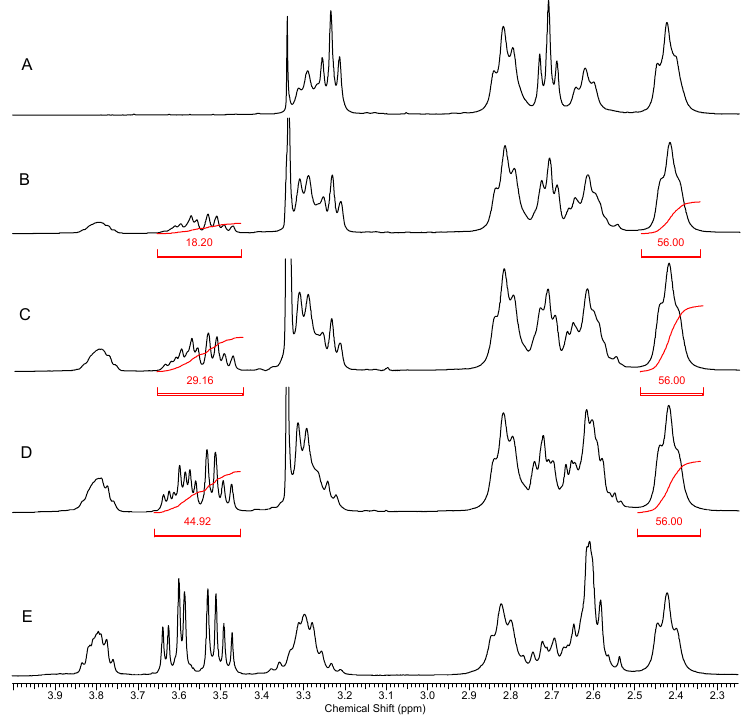
Figure 3. 1 H NMR spectra of G2 ( A ), G2 9 S gl ( B ), G2 14 S gl ( C ), G2 22 S gl ( D ), and G2 32 S gl ( E ) in D 2 O. Stepwise addition of S -glycidol resulted in an increase of proton g multiplets intensity (within 3.45–3.65 ppm) region related to internal reference triplet of a 2 a 1 a 0 triplets of overall intensity [56H]. Three G2 ngl S species were obtained, where average S gl molecules added ( n ) was 9, 14, and 22 (see Figure 3, spectra B, C, and D). The AB-type spectrum of terminal g protons of 2, 3-dihydroxypropyl substituent in G2 32 S gl (Figure 3E) is vicinally coupled with proton f. Quartets of g and g’ protons are centered at 3.61 and 3.50 ( δ AB = 0.11 ppm) with geminal coupling constant J gem = 11.7 Hz and different vicinal coupling constants J (gf) = 4.2 Hz and J (g’f) = 5.9